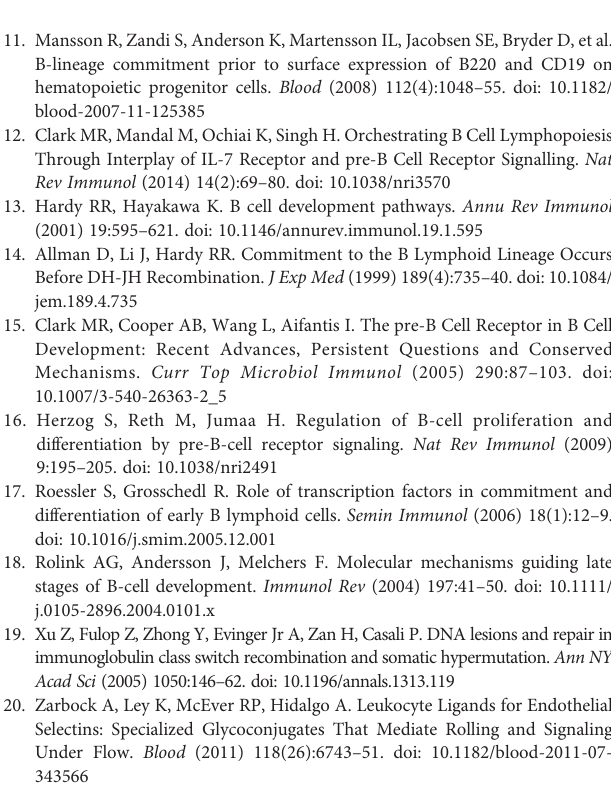
SUPPLEMENTARY FIGURE 1 | Gating strategy for human plasma cells. Representative dot plots showing the gating strategy to identify the plasma cell population in human peripheral blood. SUPPLEMENTARY FIGURE 2 | Expression of PSGL-1 in murine plasma cells. (A) Representative dot plots showing CD138 high plasma cells in the bone marrow and spleen of WT and PSGL-1 − / − mice. (B) Relative frequency of plasma cells in the bone marrow and spleen of WT and PSGL-1 − / − mice. (C, D) Percentage of PSGL- 1 + (C) and PSGL-1 MFI (D) measured in plasma cells (CD138 high ) and total B cells (B220 + CD19 + ) in the bone marrow and spleen of WT mice. (E) Representative histograms showing PSGL-1 expression in bone marrow and spleen cells of WT and PSGL-1 − / − mice. n = 10 mice per